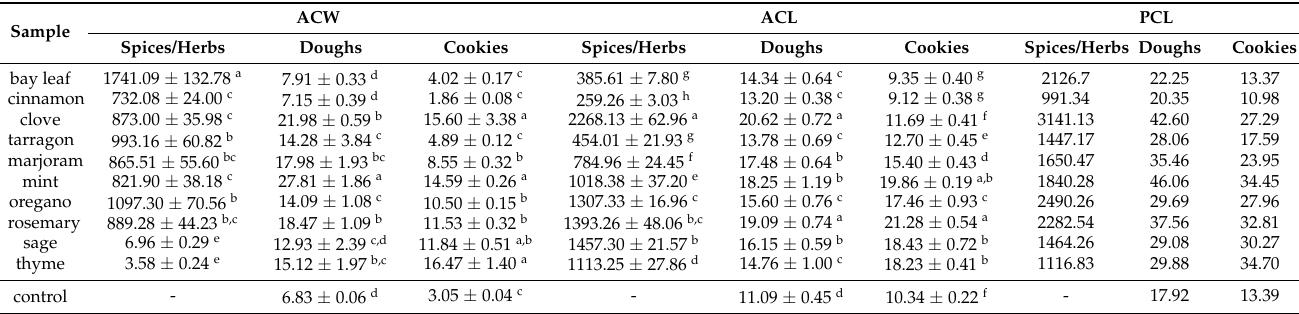
Results are expressed as mean ± standard deviation. Values in the same column followed by different superscript letters are significantly different ( p <